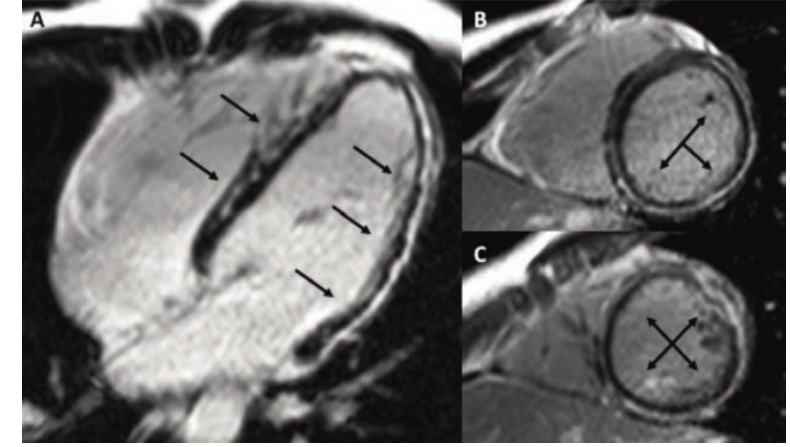
Figure 3. Cardiac magnetic resonance (CMR) imaging demonstrates subepicardial and midmyocardial left ventricular late gadolinium enhancement in a patient with arrhyth- mogenic right ventricular cardiomyopathy (ARVC). Panel (A) is a long axis four chamber image and panels (B) and (C) are short axis views.